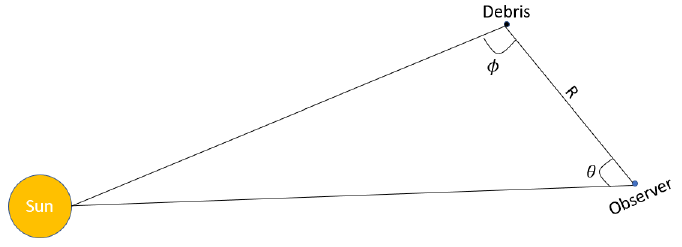
Figure 6. Schematic illustration of the Sun-object-observer geometry.